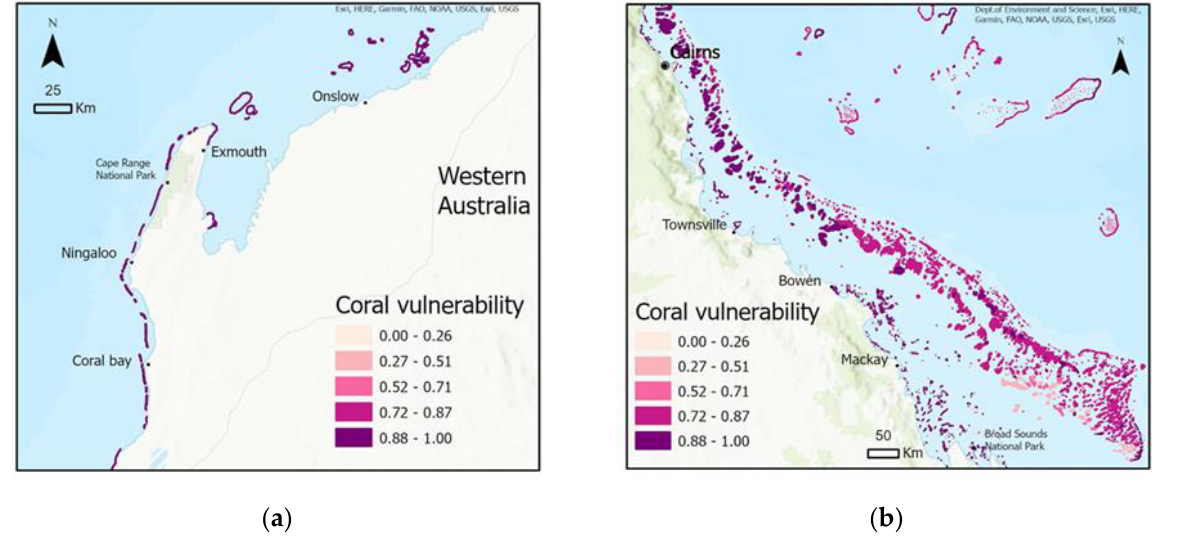
Figure 12. Coral vulnerability index maps calculated by Pareto ranking the four vulnerability indicators (depth, thermal stress, acidification, local threat) for the Ningaloo Reef ( a ) and the southern Great Barrier Reef ( b ). Higher (darker) values denote higher vulnerability of corals.